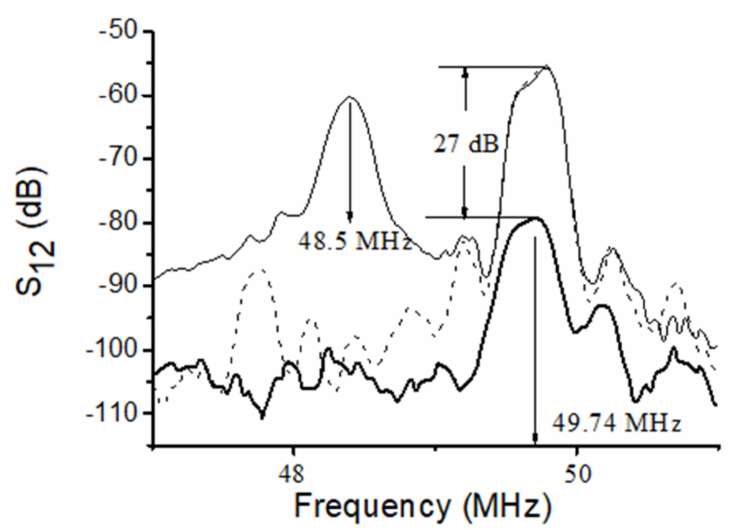
Figure 5. Insertion loss S 12 of the Lamb modes with large radiation loss (48.5 MHz) and with high sensitivity towards viscosity (49.74 MHz) measured at h = 300 µ m, λ = 300 µ m, and h/ λ = 1.0 in ST,X- quartz plate with two free faces (thin solid), one water-loaded face (dashed), and one glycerin-loaded face (thick solid). Liquids are over the propagation path L = 22 mm on the bottom of the